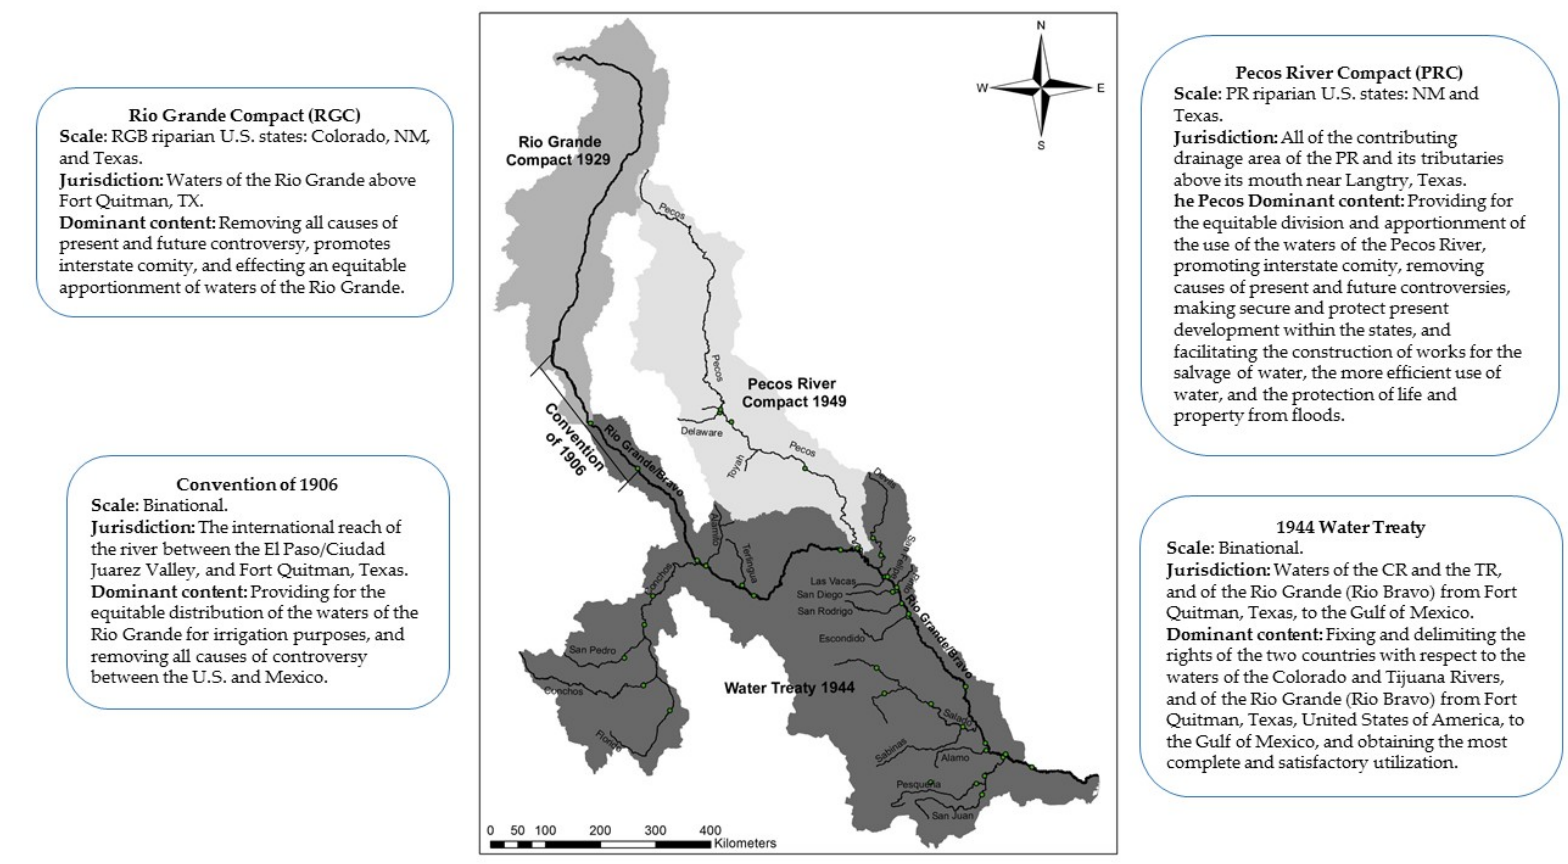
Figure 2. Mapping the legal instruments regulating water resources in the RGB Basin [30]. Edited by the first author with information from [31–34].